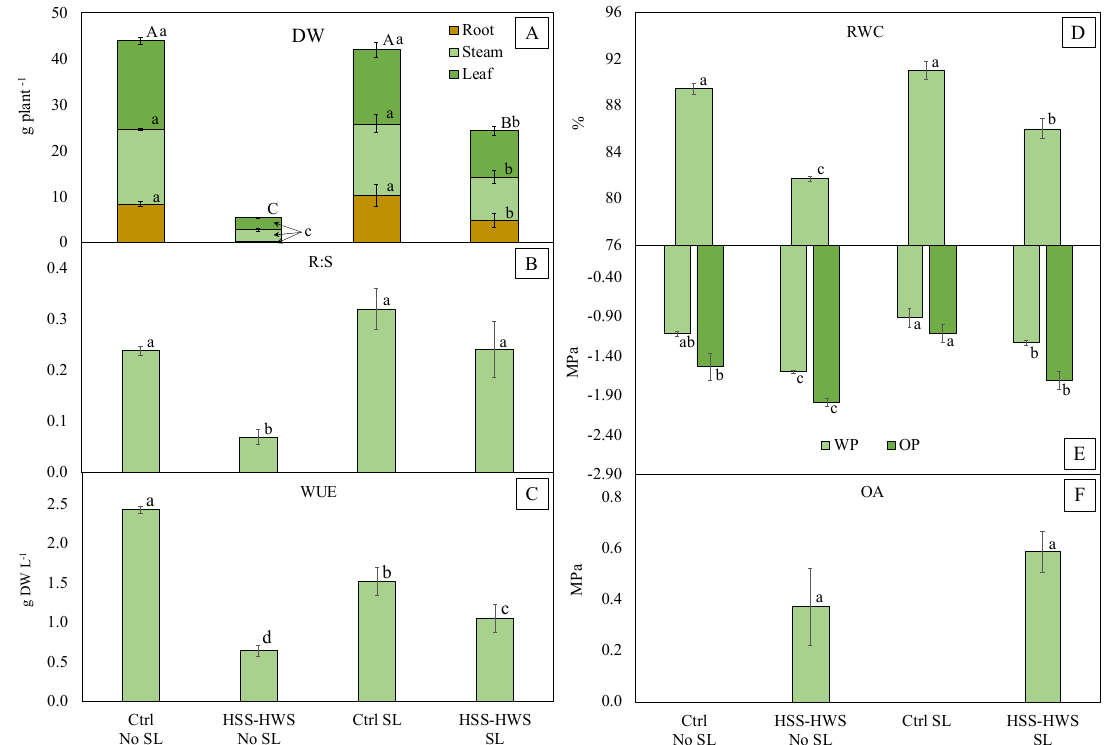
Figure 2. ( A ) Dry weight (DW); ( B ) root-to-shoot ratio (R:S); ( C ) water use efficiency (WUE); ( D ) relative water content (RWC); ( E ) water and osmotic potential (WP and OP, respectively); and ( F ) osmotic adjustment (OA) in the four treatments. Ctrl, control; HSS-HWS, high soil salinity and high water salinity; SL, salt leaching. Vertical bars indicate ± standard error (n = 3). Different letters indicate significant differences at p ≤ 0.05. In Figure 1A (DW), lowercase and uppercase letters indicate statistical differences ( p ≤ 0.05) among treatments in single organs and their totals, respectively.